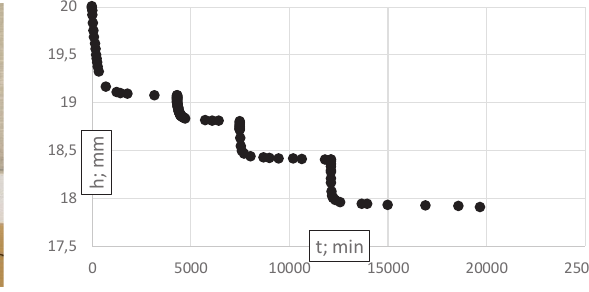
Figure 5. Oedometer test results Figure 5: Oedometer test results.